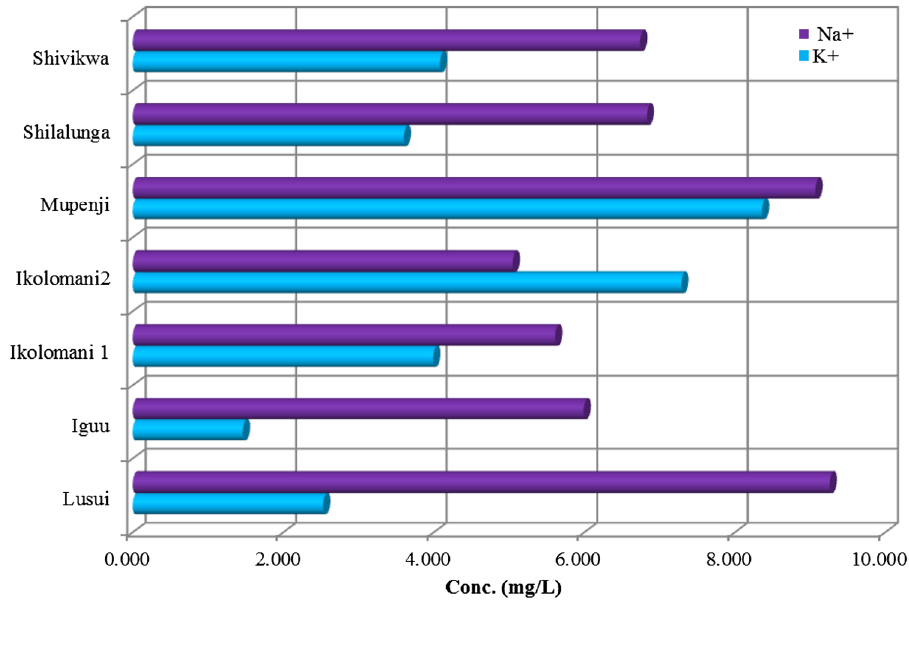
Fig. 3 The concentrations of mercury and lead in the bore-hole waters of Kakamega